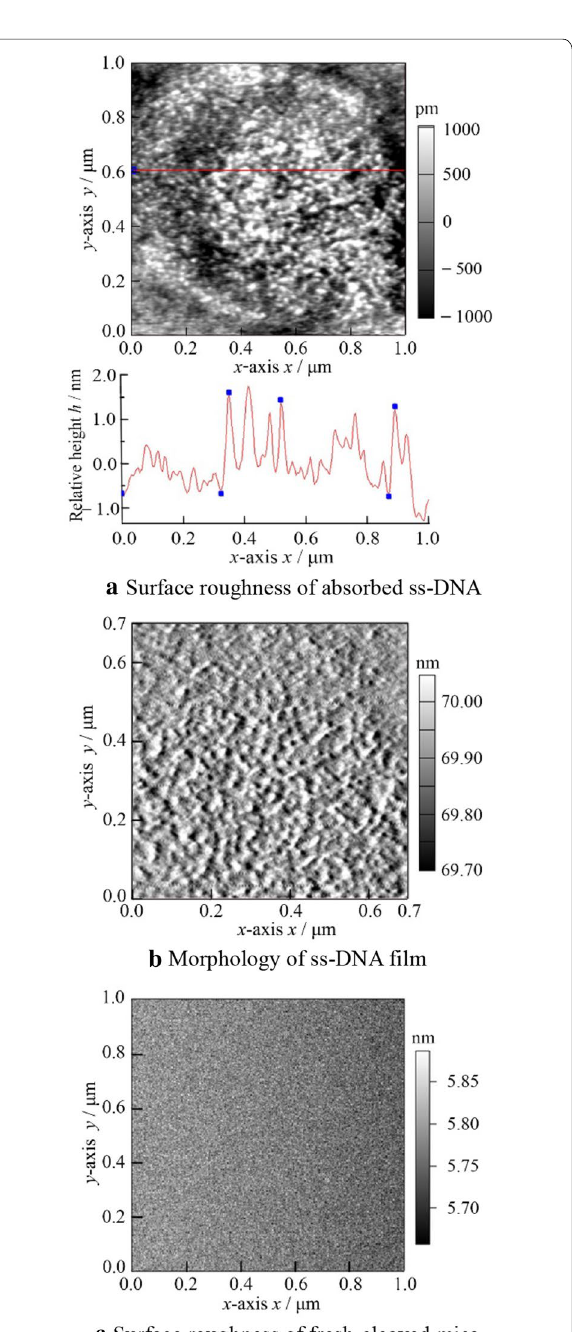
Figure 3 AFM images of ss‑DNA absorbed on mica surface from 1 mmol/L CoCl 2 with 100 ng/μL